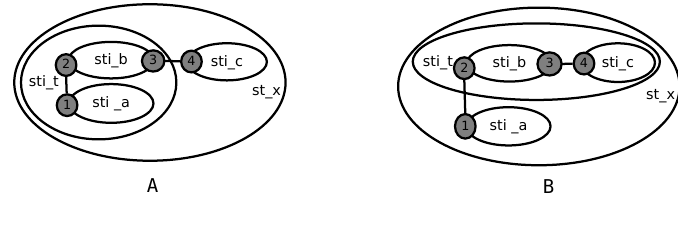
Figure 8: Different formats of the same